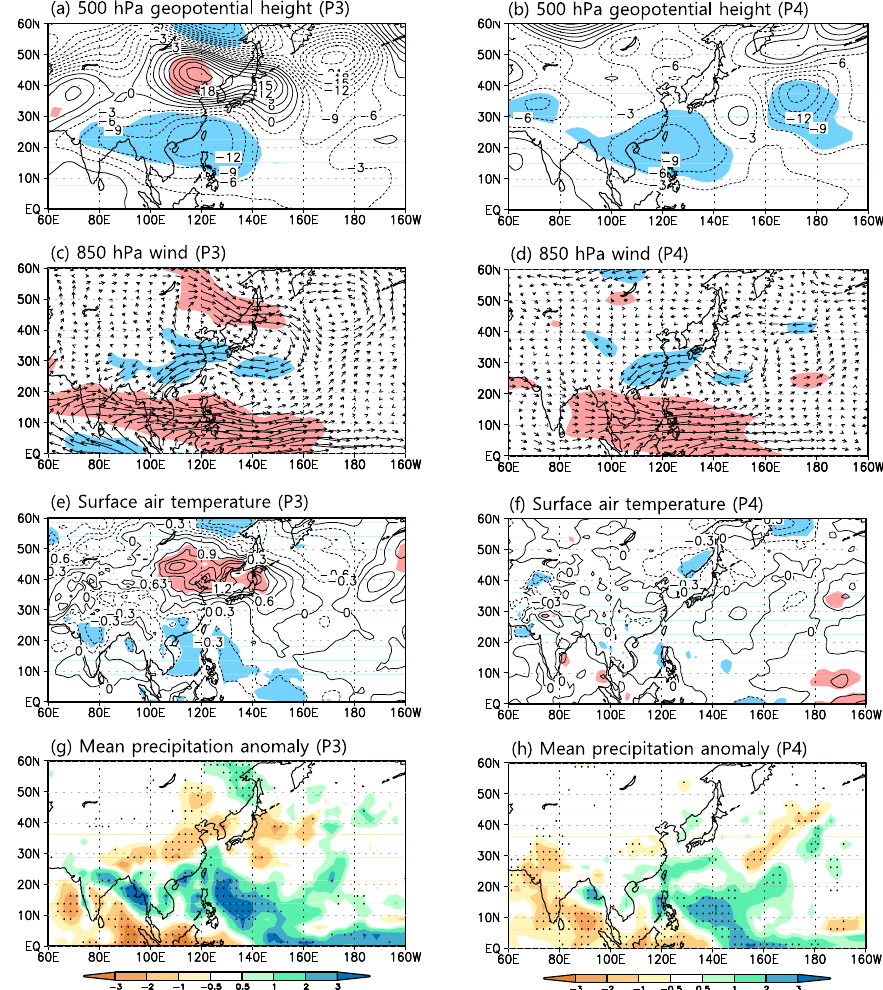
Figure 4. Regression patterns of the high pass filtered summertime 500 hPa height (( a , b ), Unit: gpm), 850 hPa wind (( c , d ), Unit: m/s), surface air temperature (( e , f ), Unit: °C) and precipitation (( g , h ), Unit: mm/day) anomalies with respect to the EASMI during the periods P3 and P4. In the height, wind, surface air temperature field, the shaded area denotes the significance at the 90% confidence level with the Student’s t -test in each period length. In the precipitation field, the shaded area indicates value and dotted area denotes the significance at the confidence level with the Student’s t -test in each period length.